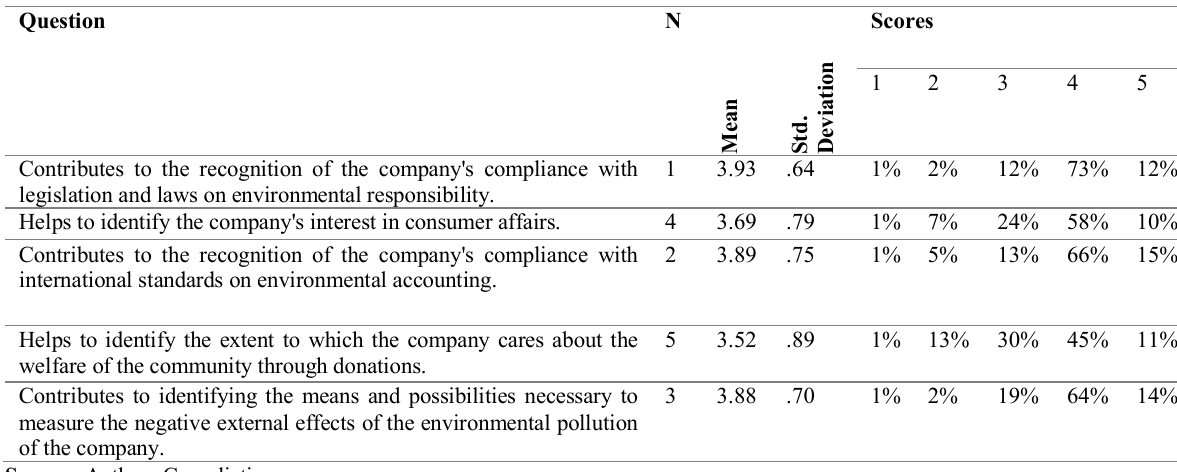
Table 8: Apply measurement models for environmental costs to increase the company's compliance with environmental